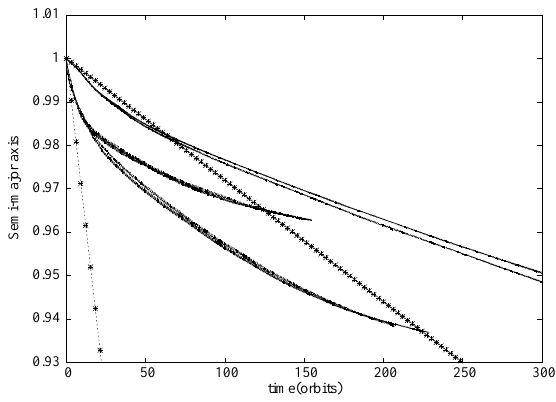
Fig. 3. Semi-major axis, in units of the initial orbital radius, as a function of time for q = 0 : 02 and q = 0 : 01 for small softening and for q = 0 : 01 with standard softening. Two curves without superimposed crosses, which are very close together, are shown for each of these three cases. The uppermost pair of curves corresponds to q = 0 : 01 with standard softening, and the lowermost pair to q = 0 : 01 with small softening. The central pair corresponds to q = 0 : 02 with small softening. The lower of the pair of curves for the cases with small softening corresponds to runs with accretion from the disk included. For the case with standard softening this situation is reversed. The straight lines with superimposed crosses are obtained adopting the initial Type I migration rate. The line with the more widely separated crosses corresponds to q = 0 : 01 with small softening while the other line corresponds to q = 0 : 01 with standard